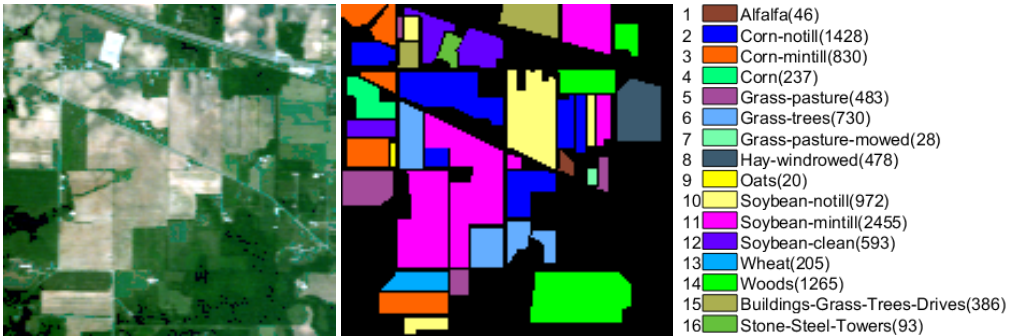
Figure 3. The false color composition and ground truth of Indian Pines data with numbers of samples for each class in